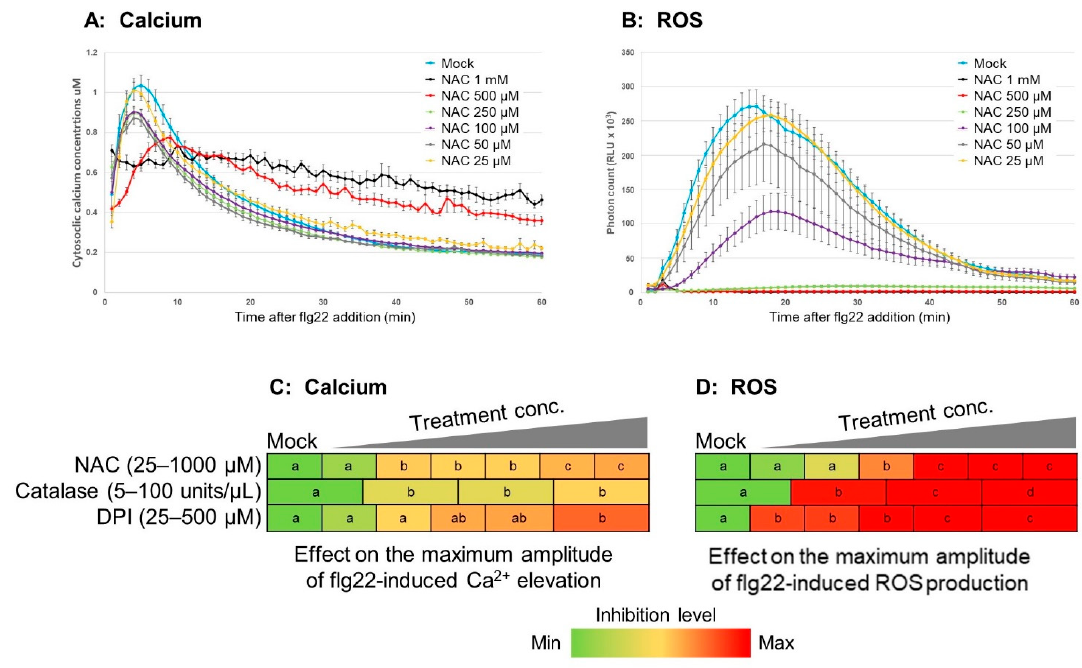
Figure 3. Effects of ROS manipulation on cytosolic calcium signaling. Line graphs show effect of the ROS scavenger NAC on flg22-induced cytosolic calcium signature ( A ) and flg22-induced apoplastic ROS signature ( B ). Heatmaps show the inhibitory effect of pharmacological agents on the maximum amplitude of flg22-induced cytosolic calcium elevation ( C ) and flg22-induced apoplastic ROS production ( D ). Leaf discs were preincubated for 30 min with the ROS scavengers NAC (25–1000 µM) and catalase (5–100 units/uL) and the NADPH oxidase inhibitor DPI (25–500 µM) prior to flg22 addition. Colors indicate the lowest level of inhibition as green and the highest level of inhibition as red. Different letters in the same row indicate statistically significant differences at p < 0.05. The data obtained from the maximum amplitude in each treat- ment were analyzed using ANOVA followed by the Tukey – Kramer multiple com-parison